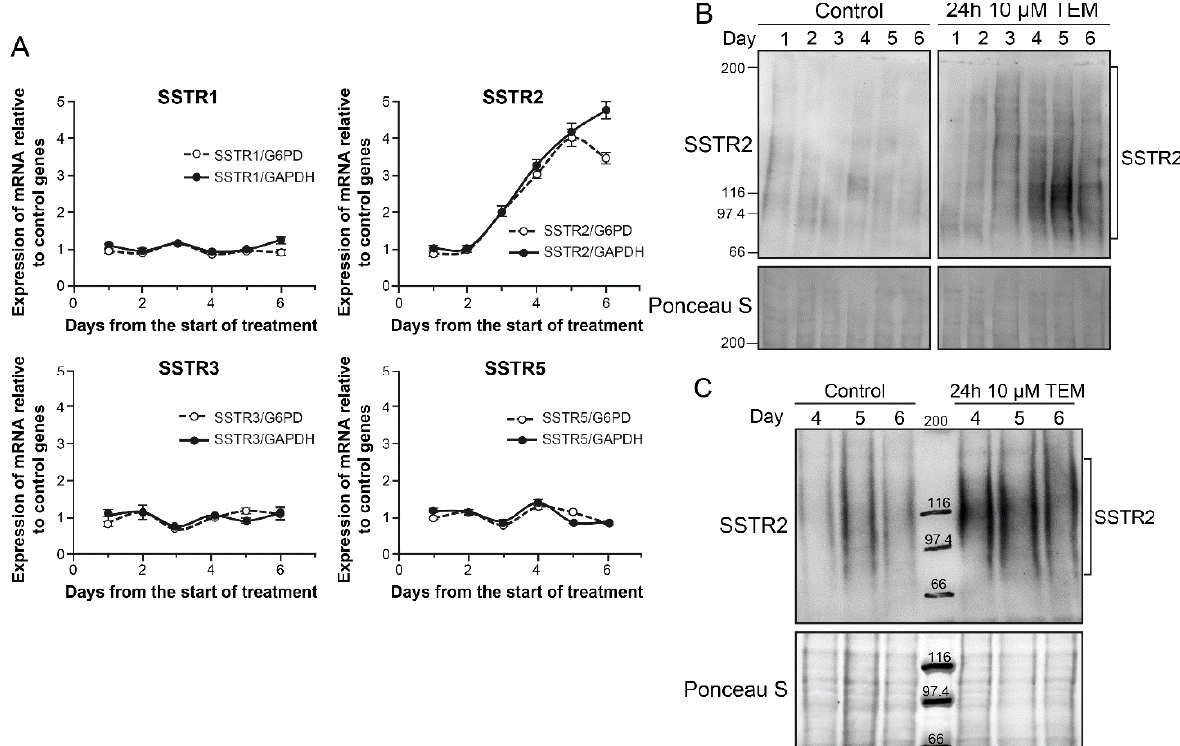
Figure 4. TEM-induced upregulation of SSTR2 in BON-1 cells and spheroids. ( A ) TEM-induced selective upregulation of mRNA for SSTR2 among five SSTR subtypes in BON-1 cells. BON-1 cells were treated with 10 µM TEM or mock-treated as controls, harvested at specified day for RNA extraction and subjected to qRT-PCR for measurement of abundance of mRNA of SSTR1-5. The data are expressed as relative abundance of copy number of the mRNA of given SSTR gene in TMZ treated cells as compared to mock control after normalization with the abundance of mRNA of two independent control genes G6PD and GAPDH in the respective samples. Each data point is presented as Mean ± SD from two independent experiments in which each sample was assessed in triplicate by qRT-PCR. The signal for SSTR4 was below detection limit in BON-1 cells. ( B ) TEM-induced upregulation of SSTR2 protein in BON-1 cells. BON-1 cells treated with 10 µM TEM, as described for panel A, were harvested on specified days and processed for immunoblotting of SSTR2. The blot represents identical results obtained in three independent experiments. ( C ) TEM-induced upregulation of SSTR2 protein in BON-1 spheroids. BON-1 spheroids were treated on the 6th day with TEM for 24 h followed by recovery in fresh medium for 6 days. The 6–12 spheroids were harvested at each day from 4–6 days post-TEM treatment, pooled and processed for immunoblotting of SSTR2.